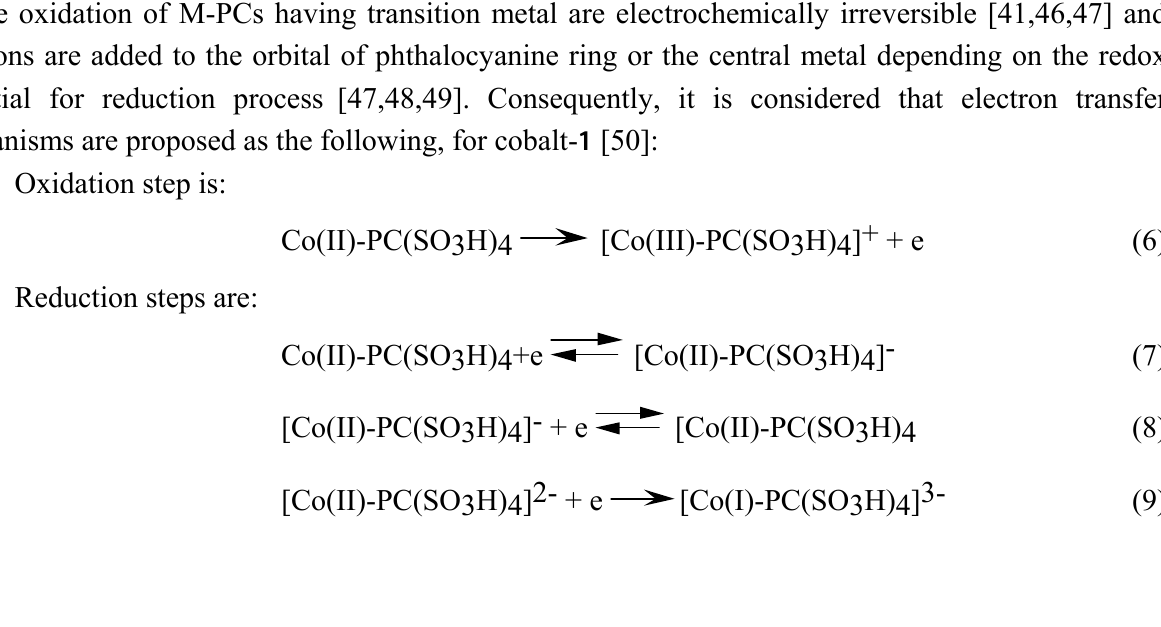
Figure 11. Variatuon of Q